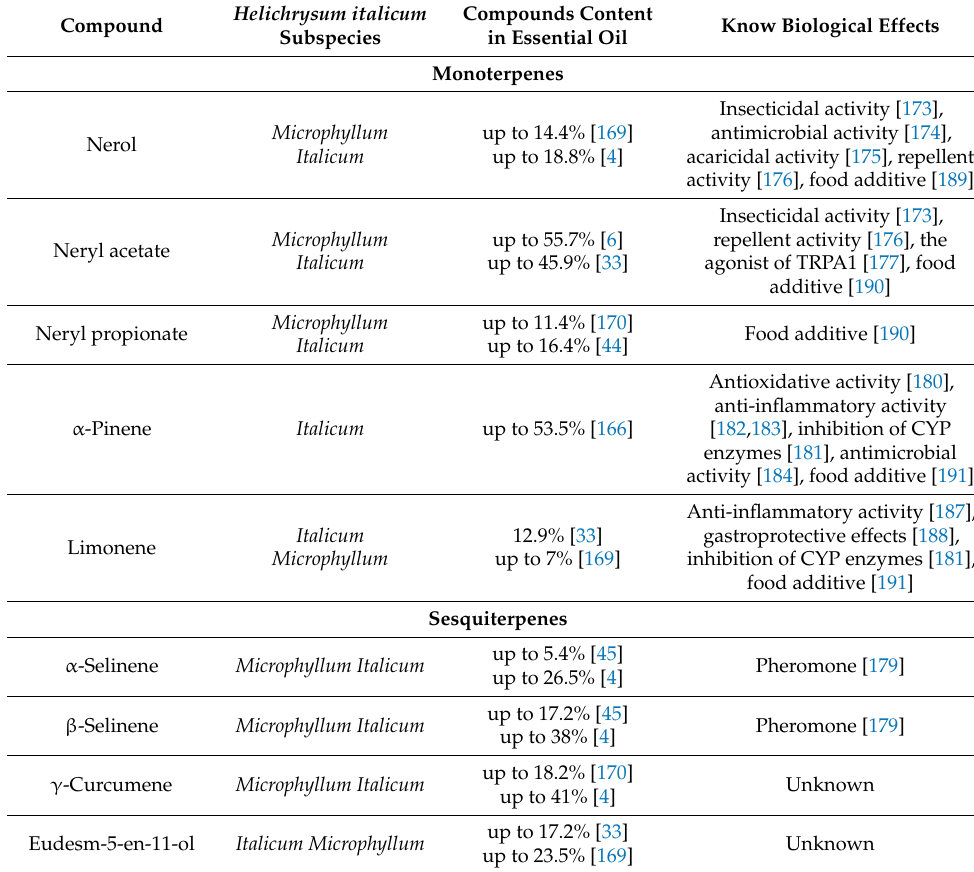
Table 4. Known biological effects of major bioactive compounds from Helichrysum italicum essential